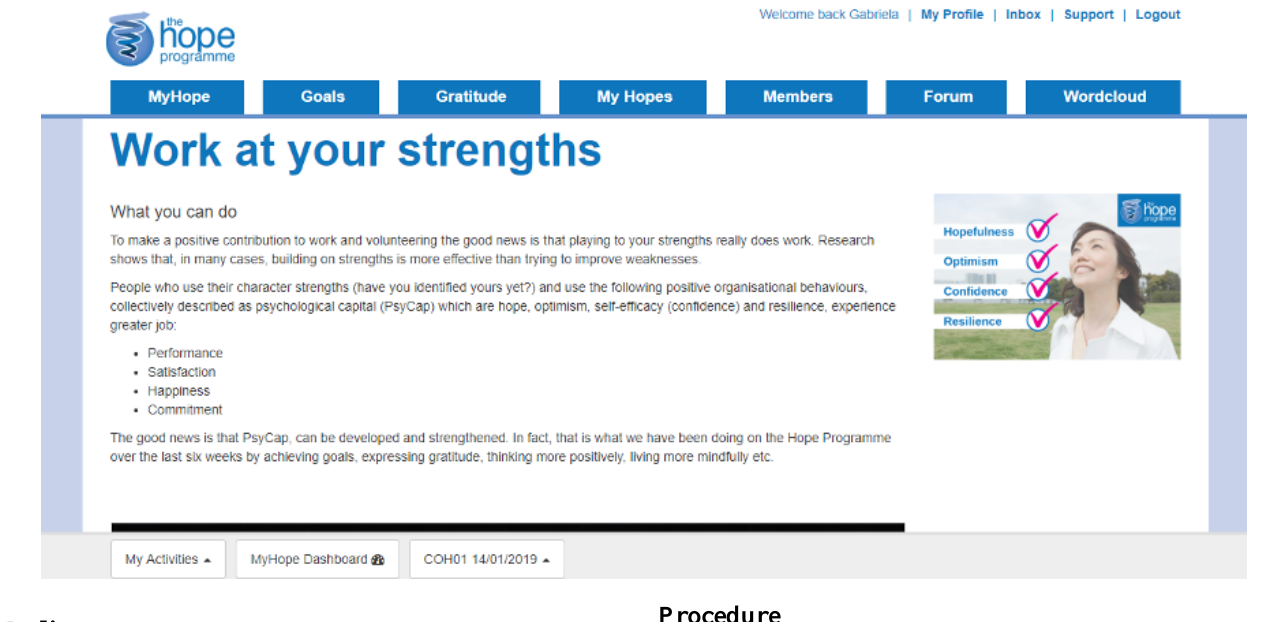
Figure 3. Help to Overcome Problems Effectively personal strengths